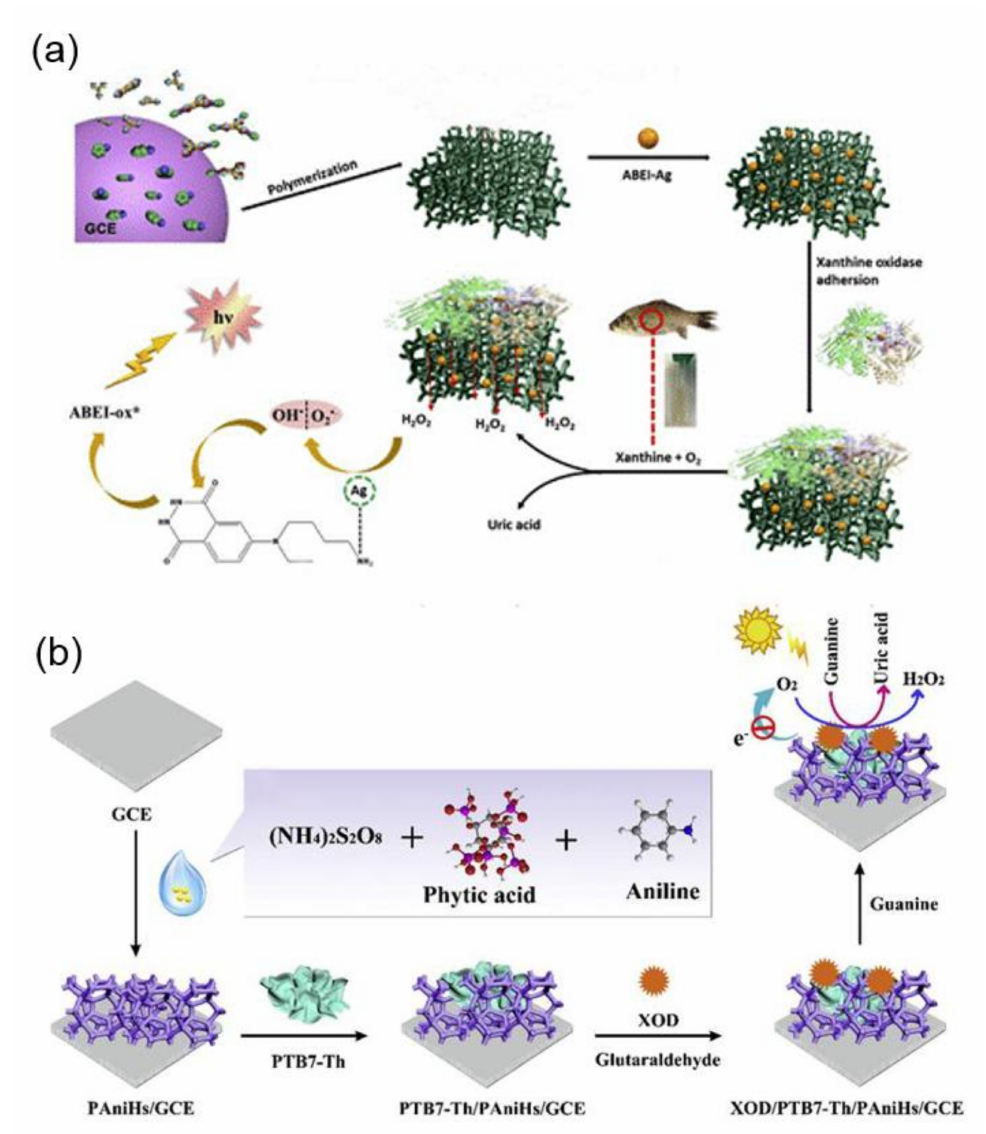
Figure 7. ( a ) 3D PANI hydrogel-based electrochemiluminescent sensors for xanthine detection